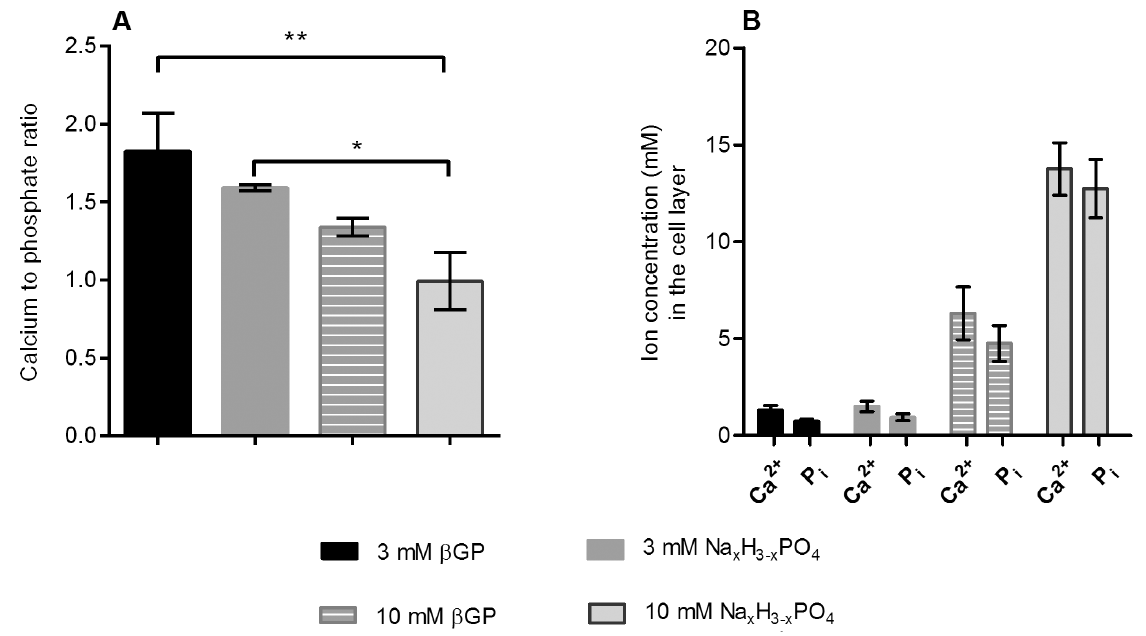
Figure 6. Calcium to phosphate ratios and ion concentration in the cell layer. A. Calcium to phosphate ratio. Calcium and phosphate ions were extracted from the cell layer of four different donors and quantified. Data are mean 6 SD for n=4 donors. B. Calcium and phosphate content of the cell layer after 28 days of osteogenic induction with different phosphate additives. Data are mean 6 SD for n=4 donors.